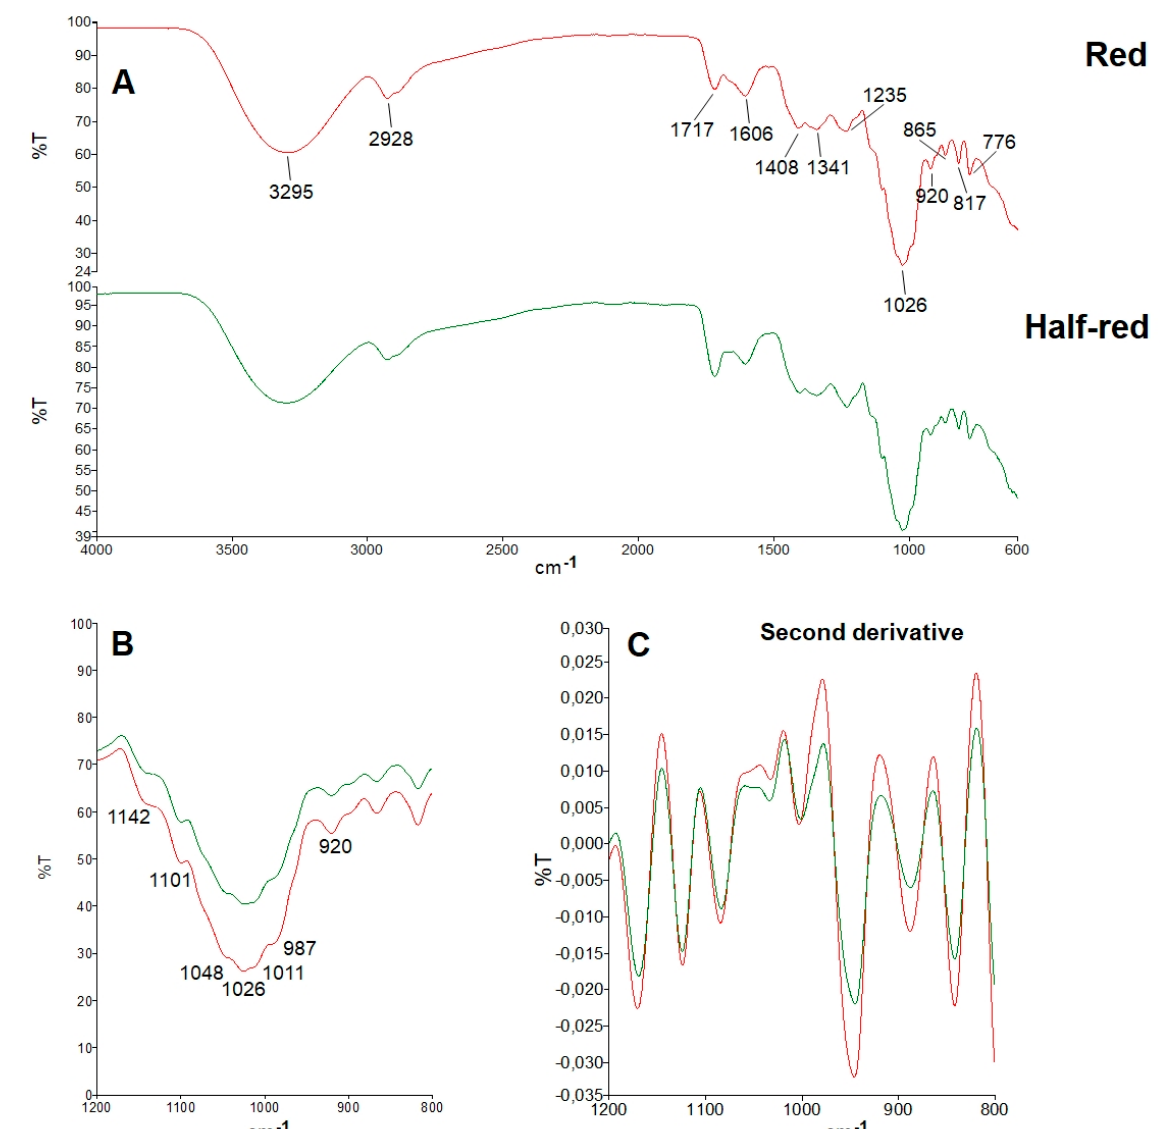
Figure 3. (Panel ( A )): Typical ATR-FTIR spectrum in the 4000–600 cm − 1 range of freeze-dried red (red line) and half-red (green line) strawberries. (Panel ( B )): Magnified view of the spectral fingerprint region (1200–800 cm − 1 ), dominated by vibrational modes of sugars. (Panel ( C )): Second derivative of spectra in the 1200–800 cm − 1 .